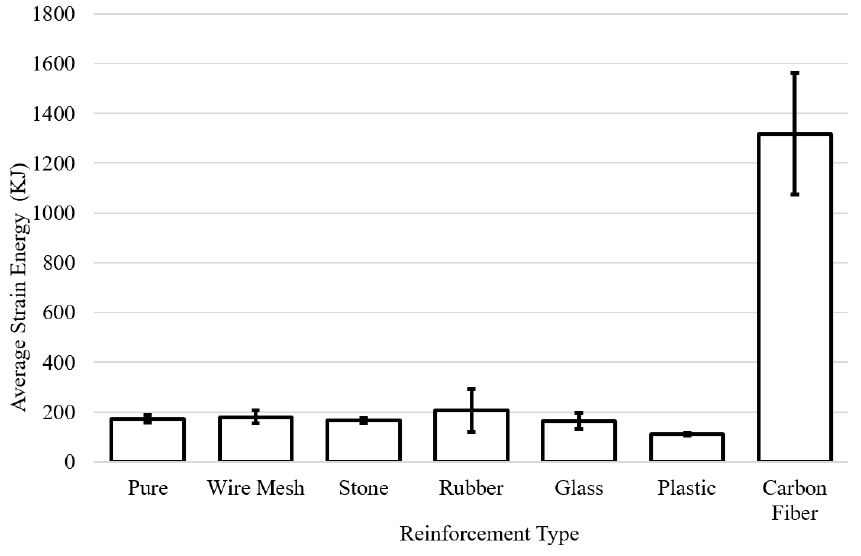
Figure 8. Average Strain Energy of Each Reinforcement Type.